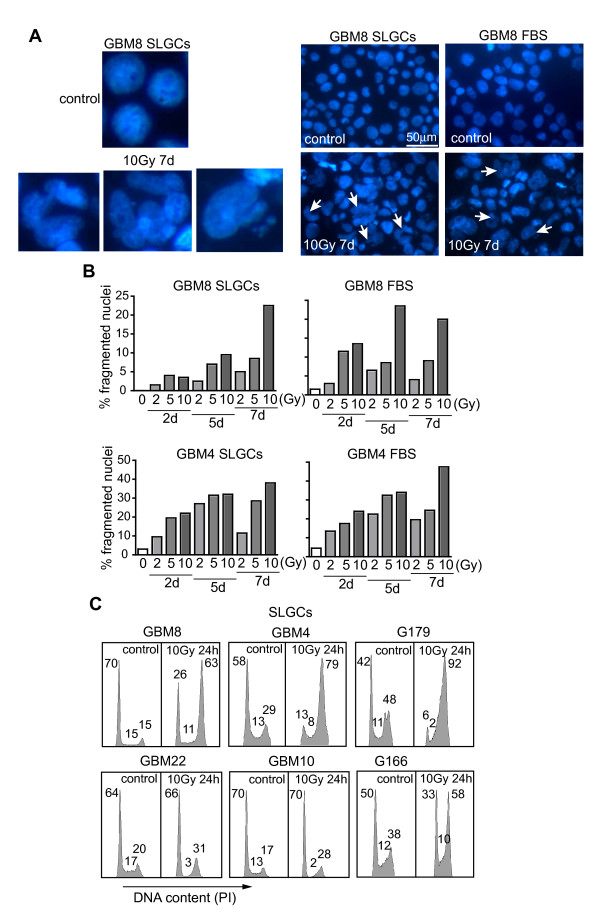
γ IR-induced mitotic catastrophe and cell cycle arrest in SLGCs. SLGCs and FBS cultures were irradiated with 0, 2, 5, or 10 Gy, and DAPI-stained cells with signs of mitotic catastrophe (micro- and multinucleated cells) were detected microscopically (A) and counted (B) at the time points indicated. C. γIR-induced cell cycle arrests in SLGC cultures. Exponentially growing cells were irradiated with 10 Gy and 24 h later cell cycle analysis was performed by flow cytometry. The percentages of cells in the different cell cycle phases are indicated. In each panel, one of two experiments with similar results is shown.